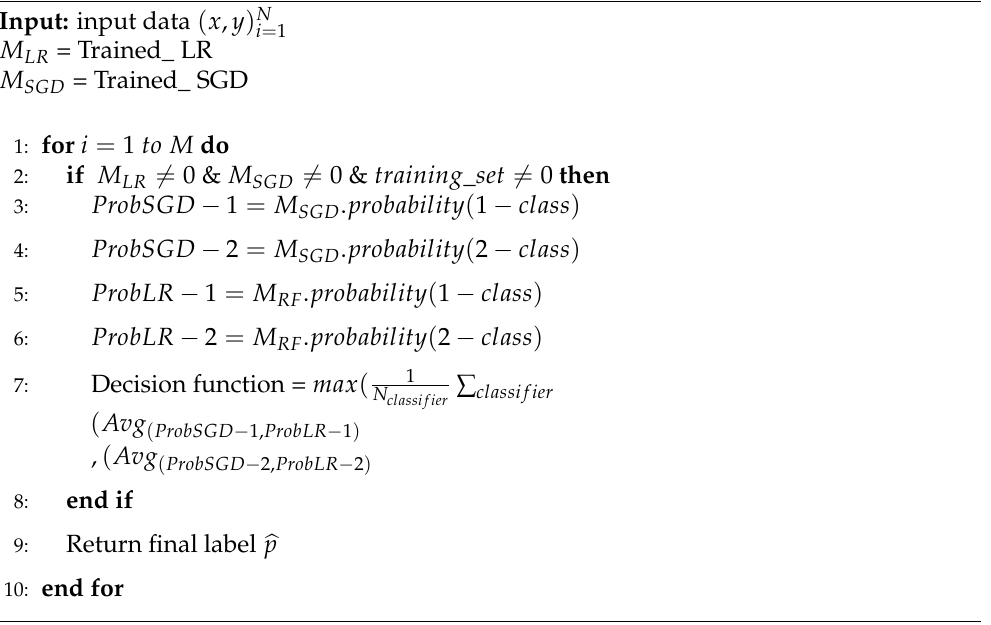
Figure 3. Architecture of the proposed voting classifier. Algorithm 1 Ensembling of LR and